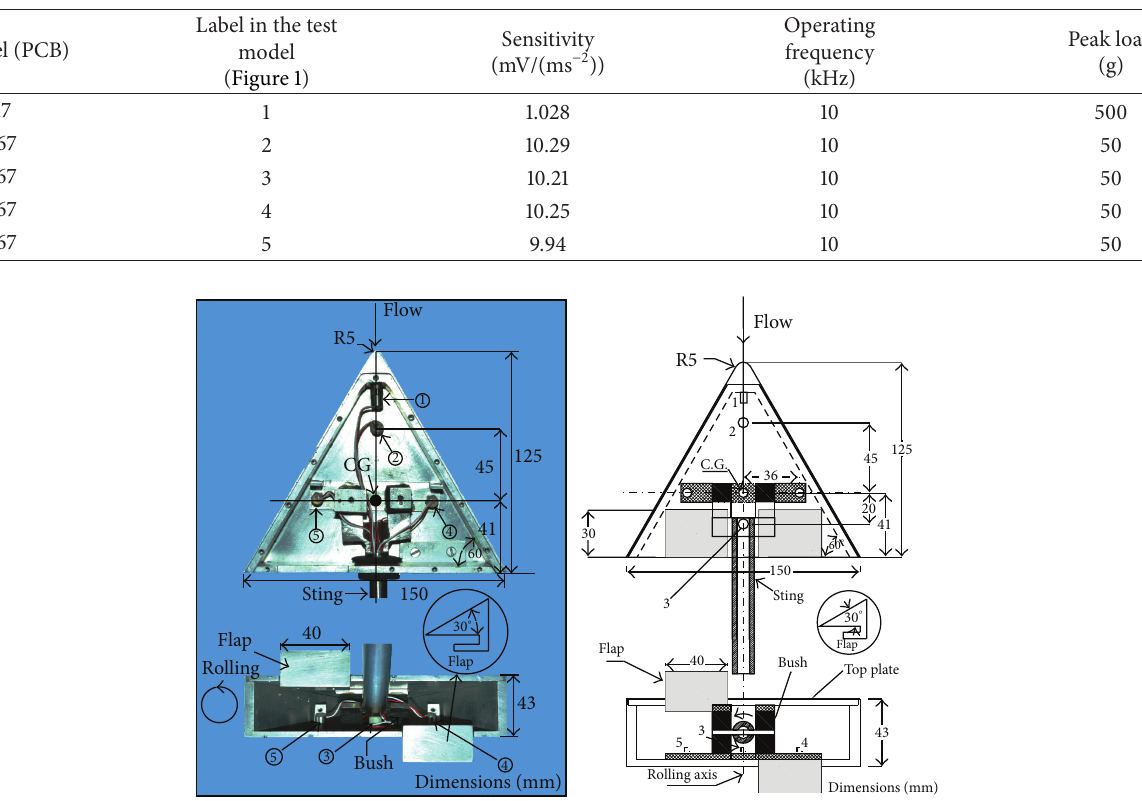
Figure 1: Photograph and schematic of test model assembly. Labels 1–5 indicate accelerometers.